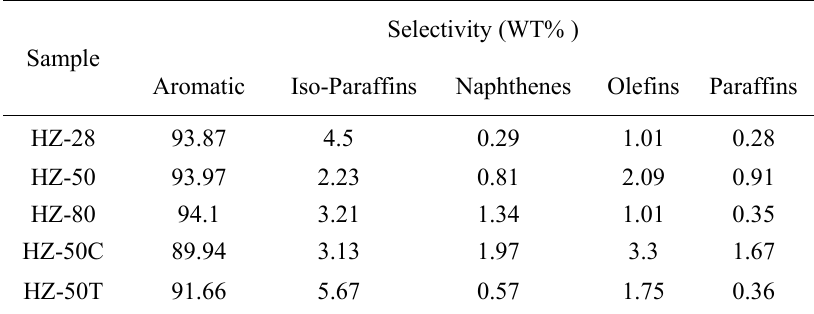
Table .6. Weight selectivity of hydrocarbon compounds in the liquid product of HZ-28, HZ-50, HZ-80,